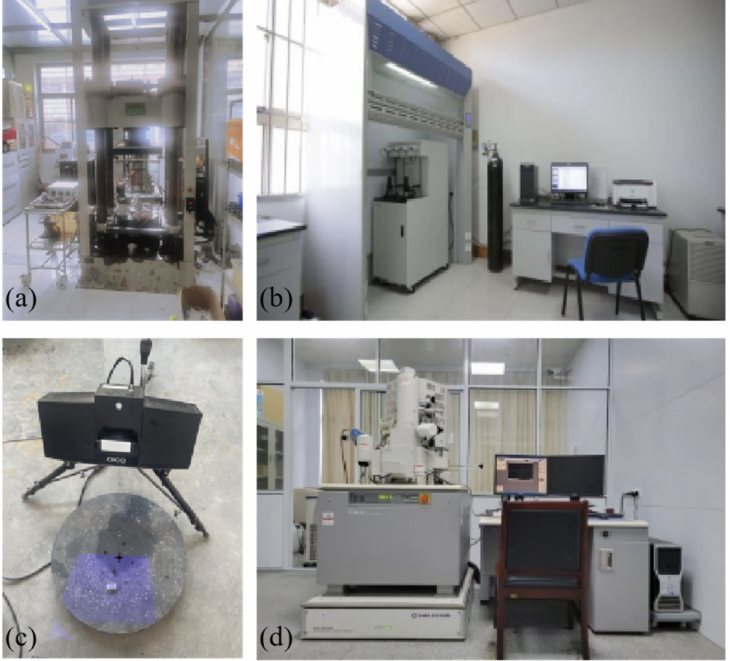
Figure 5. The testing machine: ( a ) the triaxial testing machine of XTR01-01, ( b ) the mercury porosime- ter of Micromeritics AutoPore V 9620, ( c ) the 3D scanner of OKIO-3M-400-200-100, and ( d ) the scanning electron microscope of Hitachi